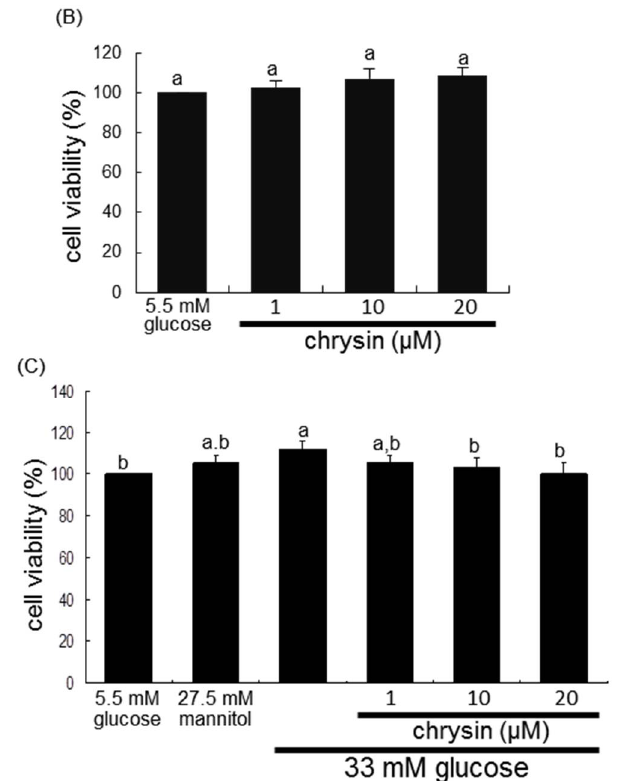
Figure 1. Chemical structure ( A ) and cytotoxicity ( B ) of chrysin and inhibition of glucose-exposed human renal mesangial cell (HRMC) outgrowth by chrysin ( C ). Human renal mesangial cells were challenged with 5.5 mM glucose, 5.5 mM glucose plus 27.5 mM mannitol as osmotic controls or with 33 mM glucose in the absence and presence of 1–20 μM chrysin. Values of cell viability are mean ± standard error of mean (SEM, n = 5) and expressed as percent cell survival relative to 5.5 mM glucose (cell viability = 100%). Values in bar graphs not sharing a same lower case indicate significant different at p < 0.05.